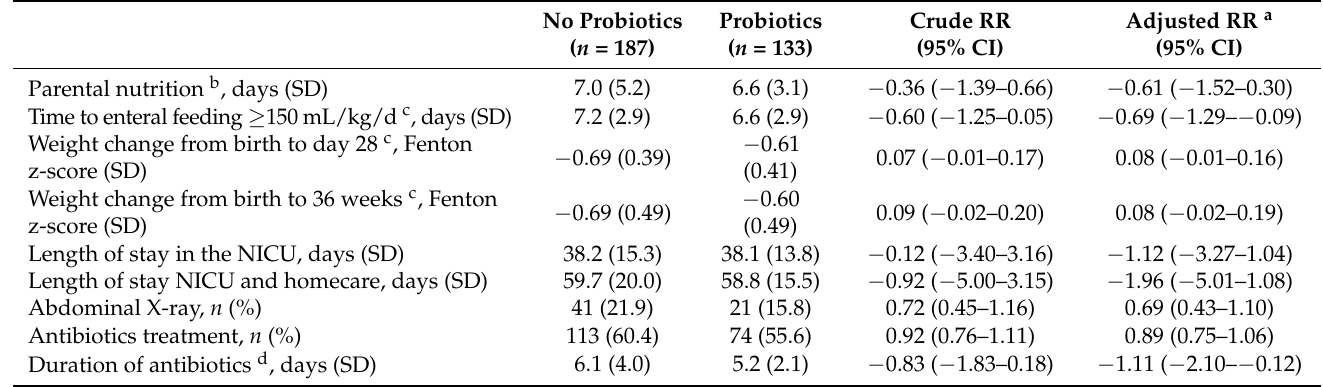
Table 4. Feeding tolerance, growth, and other secondary outcomes in 320 very preterm infants without death, sepsis, and/or necrotising enterocolitis